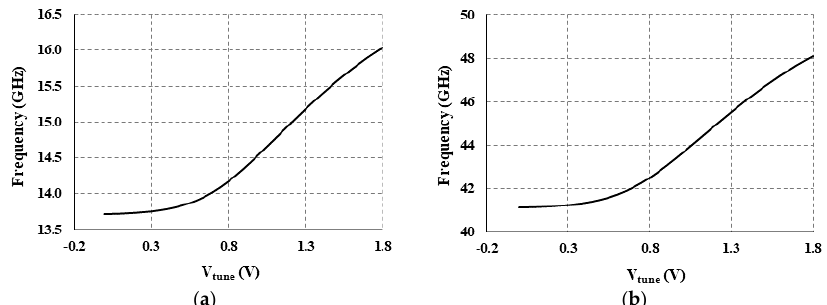
Figure 8. Simulated VCO tuning range ( a ) output of the VCO; ( b ) output of the triple.